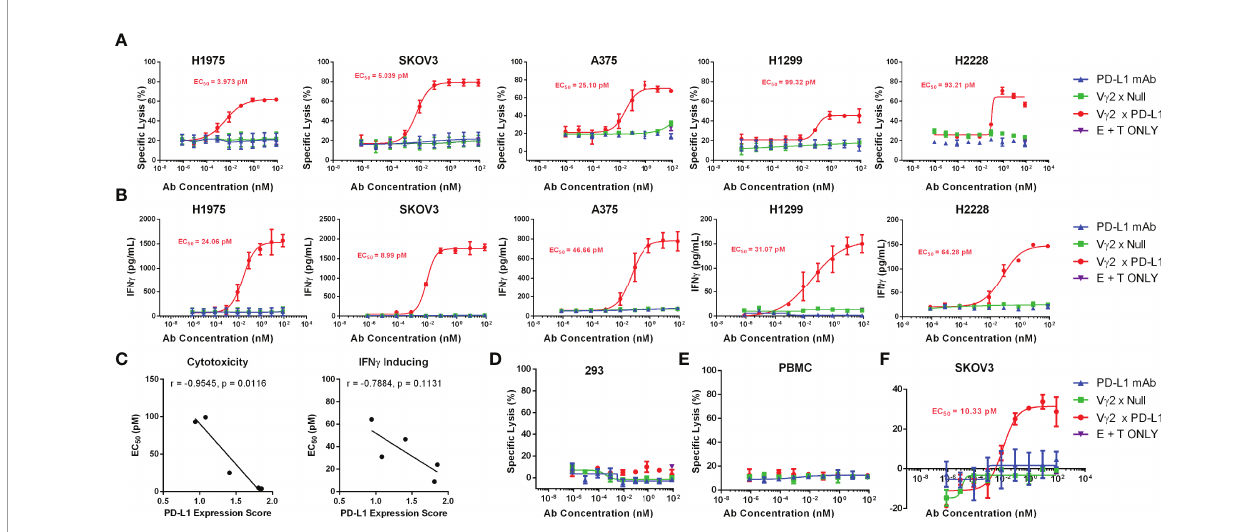
FIGURE 6 | V g 2 x PD-L1 redirects V g 2V d 2 T cells to kill ef fi ciently various PD-L1 positive cancer cell lines in vitro , but spared this effect on PD-L1 negative expressing HEK-293 cells or unrelated healthy PBMCs. (A) Expanded V g 2V d 2 T cells derived from healthy donors ’ PBMCs (n=3) were incubated with various luciferase-expressing tumor cell lines at a 0.5:1 ratio under the stimulation of serial concentrations of antibodies, including V g 2 x PD-L1, V g 2 x Null or PD-L1 mAb, for 12 hours. (B) Increased IFN g secretion in the above co-cultures. (C) The cytotoxicity and IFN g induction of V g 2V d 2 T cells revoked by V g 2 x PD-L1 correlated with the PD-L1 expression score. The spearman ’ s r and two-tailed p values were calculated by GraphPad Prism 6. (D, E) The expanded V g 2V d 2 T cells derived from healthy donors ’ PBMCs (n=3) were incubated with CFSE-labelled PD-L1 neg HEK-293 (D) or allogeneic PBMCs (E) at 1:1 ratio as indicated in (A) . A CFSE/PI staining-based fl ow cytometry method to determine the killed target cell percentages. (F) Fresh V g 2V d 2 T cells enriched from healthy donors (n=2) were incubated with SKOV3-Luc at 5:1 ratio under the stimulation of serial concentrations of antibodies, including V g 2 x PD-L1, V g 2 x Null or PD-L1 mAb, for 12